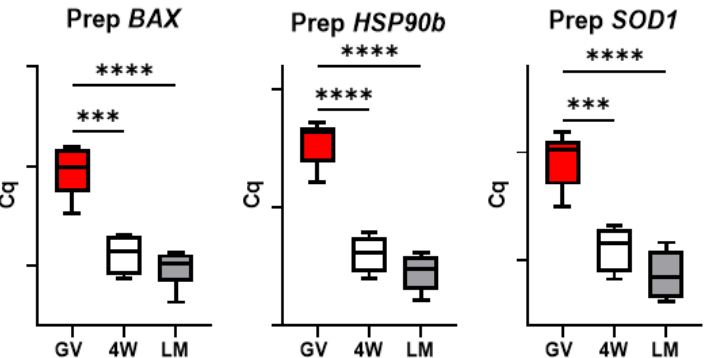
Figure 4. Expression of genes involved in cell stress response in pools of prepubertal GV and MII oocytes matured in 4-well plates (4W) or in liquid marbles (LM). Target gene expression was nor- malized against the l uciferase exogenous control. Relative abundance is expressed as ΔC q ( Y -axis). Each box represents the mean expression of 5 replicate pools of 10 oocytes each (mean ± SE). Signif- icant differences were assessed by ANOVA general linear model test; *** p < 0.001 **** p < 0.0001.